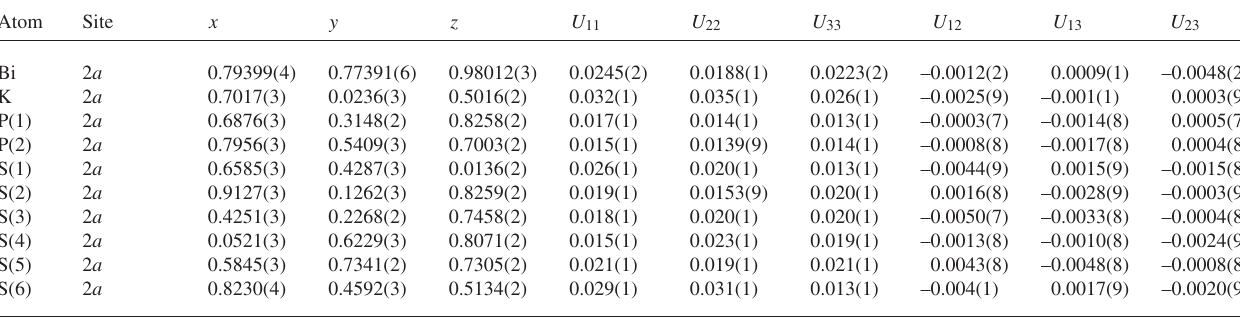
Table 2. Atomic coordinates and displacement parameters (in Å 2 )